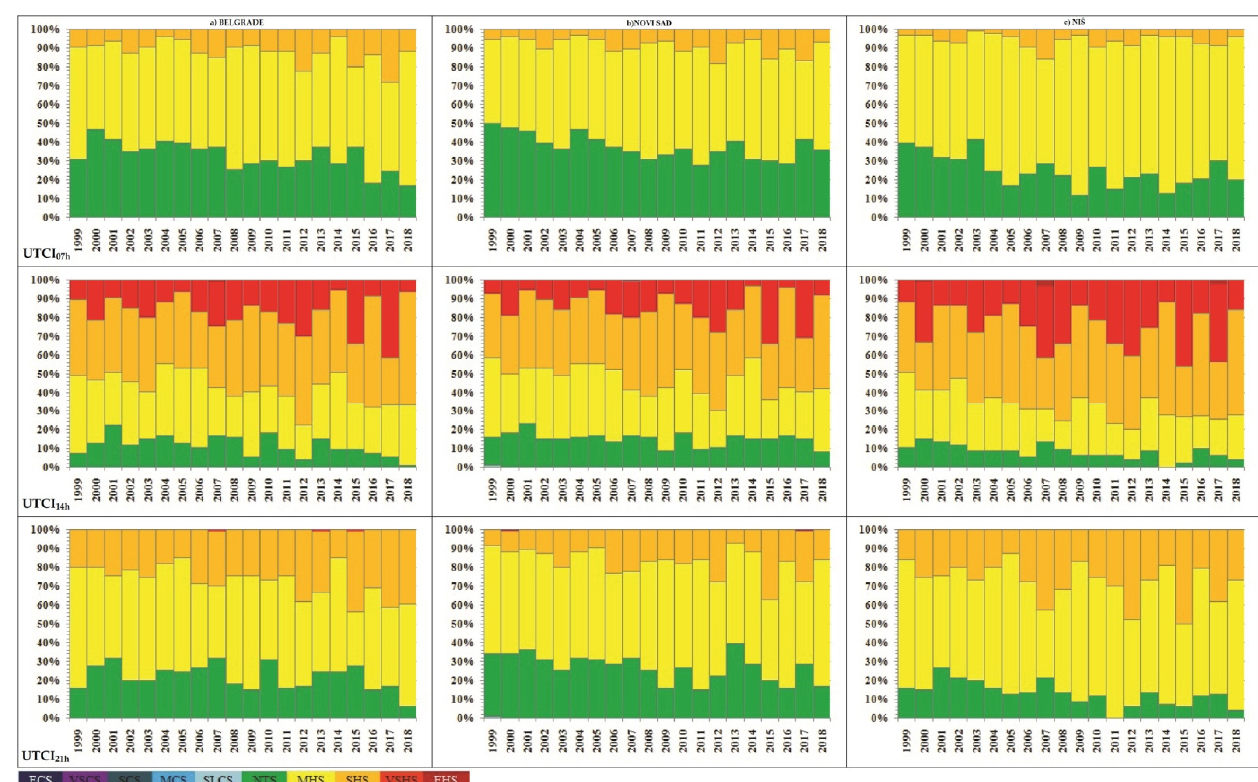
Figure 3. Frequencies of different cold and heat stress category in ( a ) Belgrade; ( b ) Novi Sad; and ( c ) Niš based on UTCI 07h (first column), UTCI 14h (second column), UTCI 21h (third column) during summer, over a period of 20 years (1999–2018).